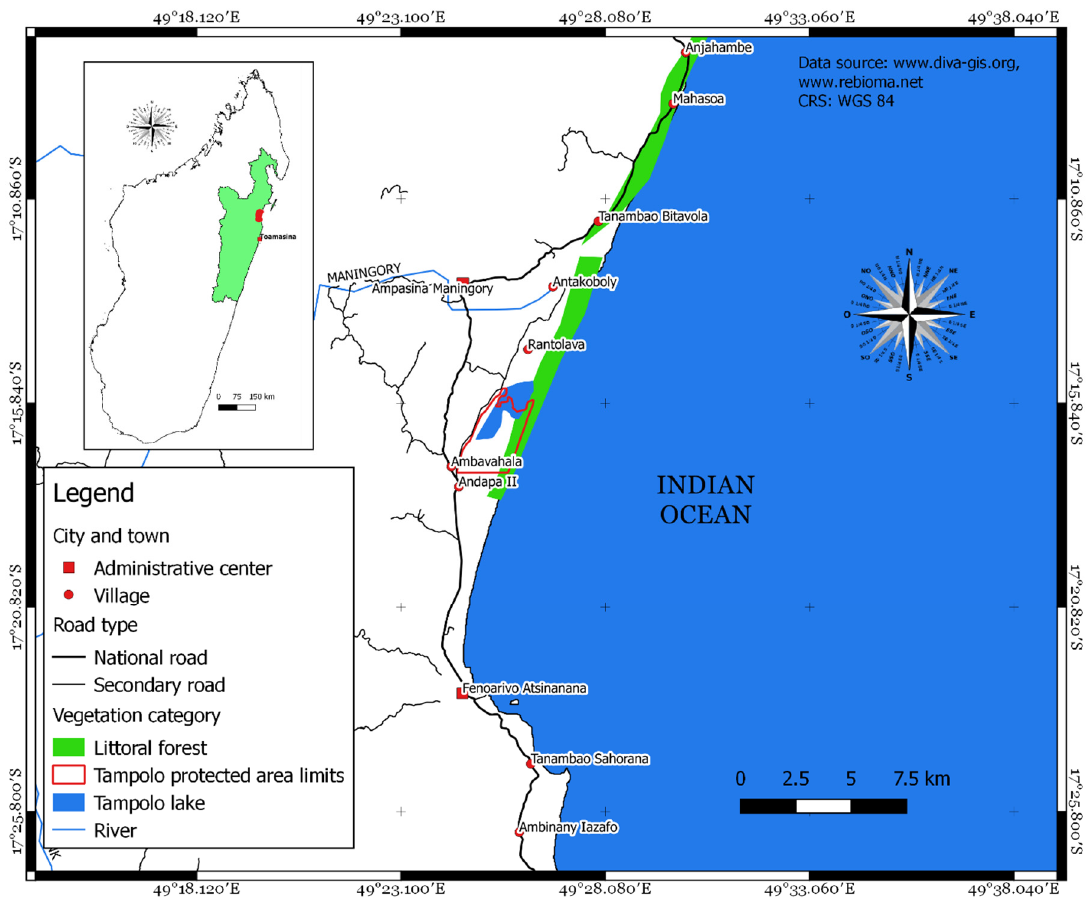
Figure 1. Map of the study area : Location of Tampolo forest and the adjacent communities living around the forest.